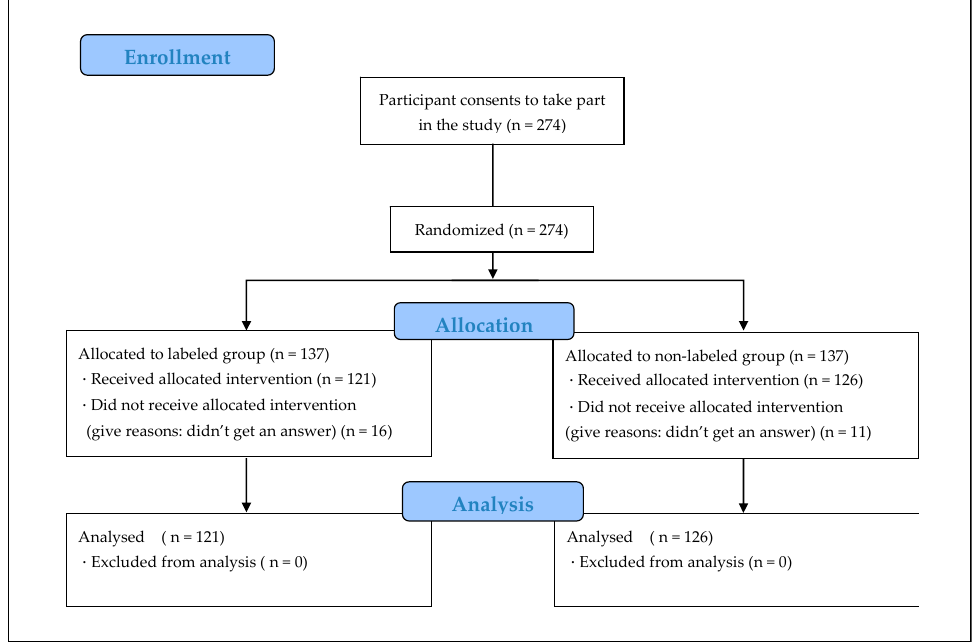
Figure 1. Flowchart of participant allocation. Table 1. Demographic and baseline characteristics of the study participants in the intervention and control